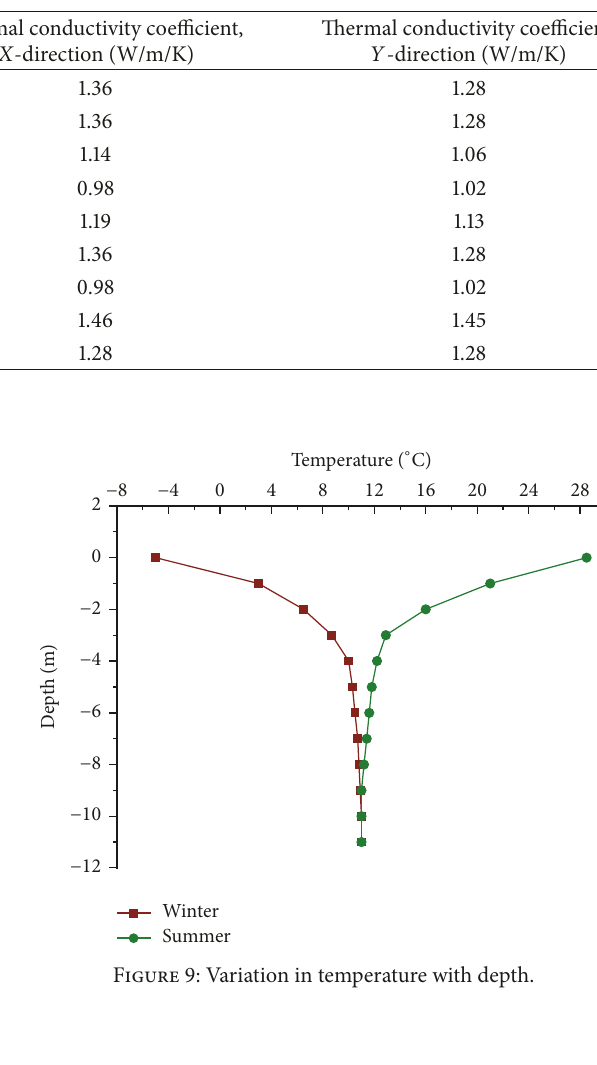
Table 2: Thermal parameters of different layers of host soil and concrete.